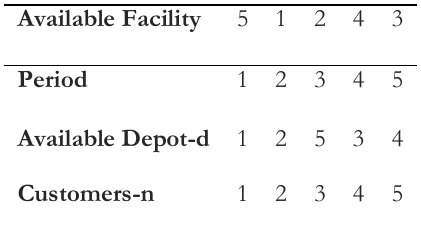
Table 6. Example of 5 facilities and 2